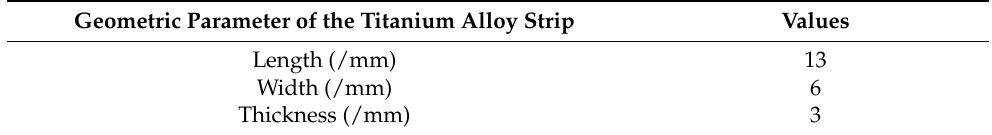
Table 2. Geometric parameter of the titanium alloy